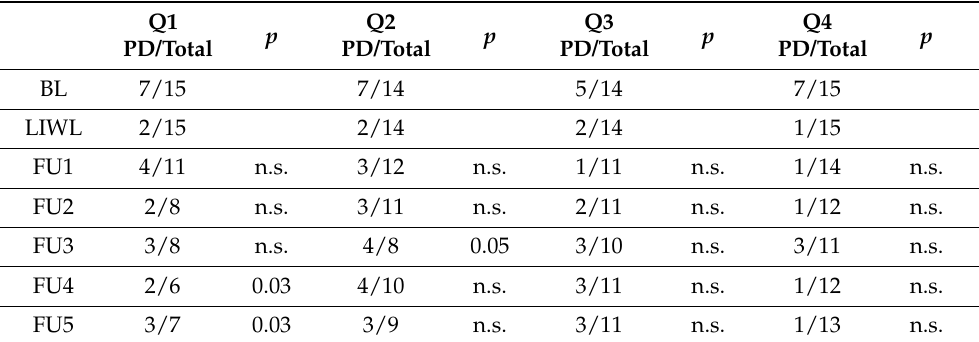
Table 7. Table showing absolute numbers of participants with prediabetes (PD) after LIWL during 5 years of follow-up and the total number of participants at the indicated timepoints in each quartile (Q1–Q4). Q1